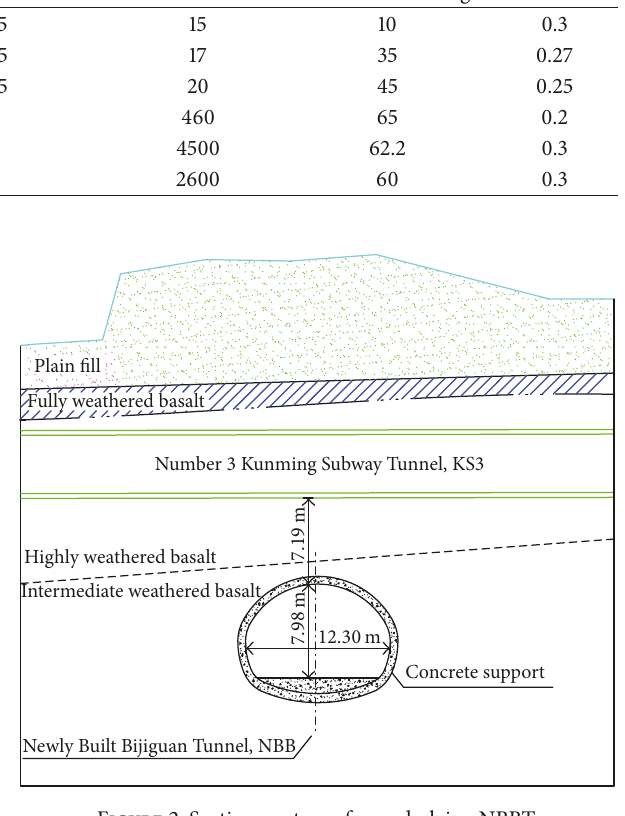
Figure 2: Section contours for underlying NBBT.